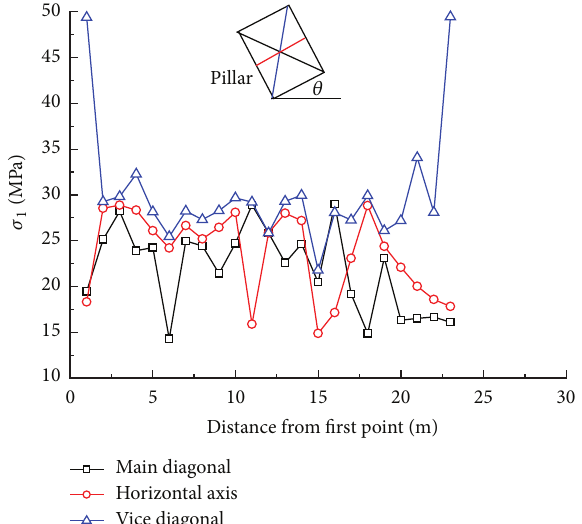
Figure 23: Variation of 𝜎 1 with distance from the first point (dip angle =